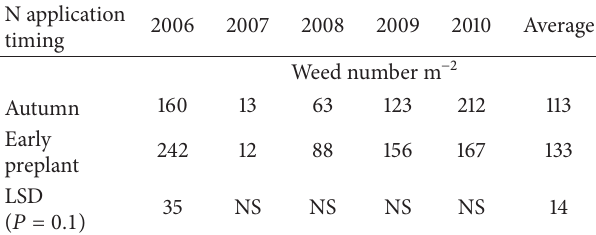
Table 3: Winter annual weed number in the spring following N application timings. Data were averaged over N